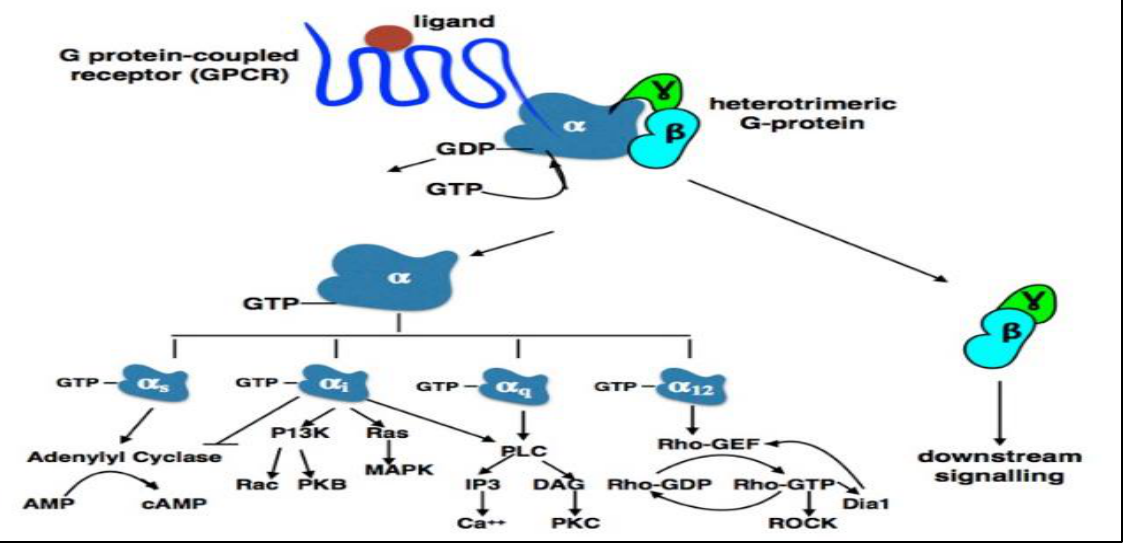
Figure 3. Baseline signalling pathways of GPCRs. GDP-guanosine diphosphate, GTP-guanosine triphosphate, AMP-adenosine monophosphate, cAMP-cyclic adenosine monophosphate, PI3K- phosphatidylinositol-3-kinase, Rac- a member of the Rho family of GTPases, PKB- protein kinase B